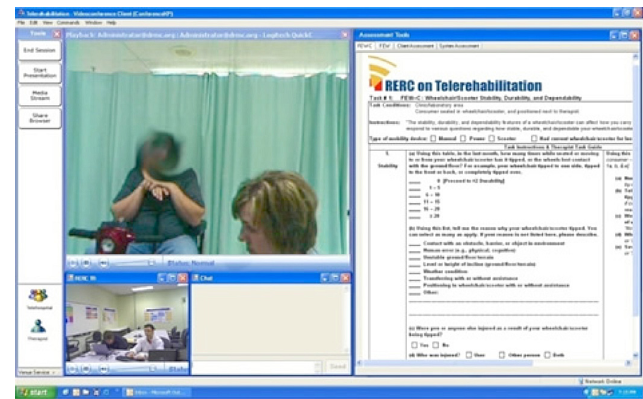
Figure 6. Customized Videoconferencing